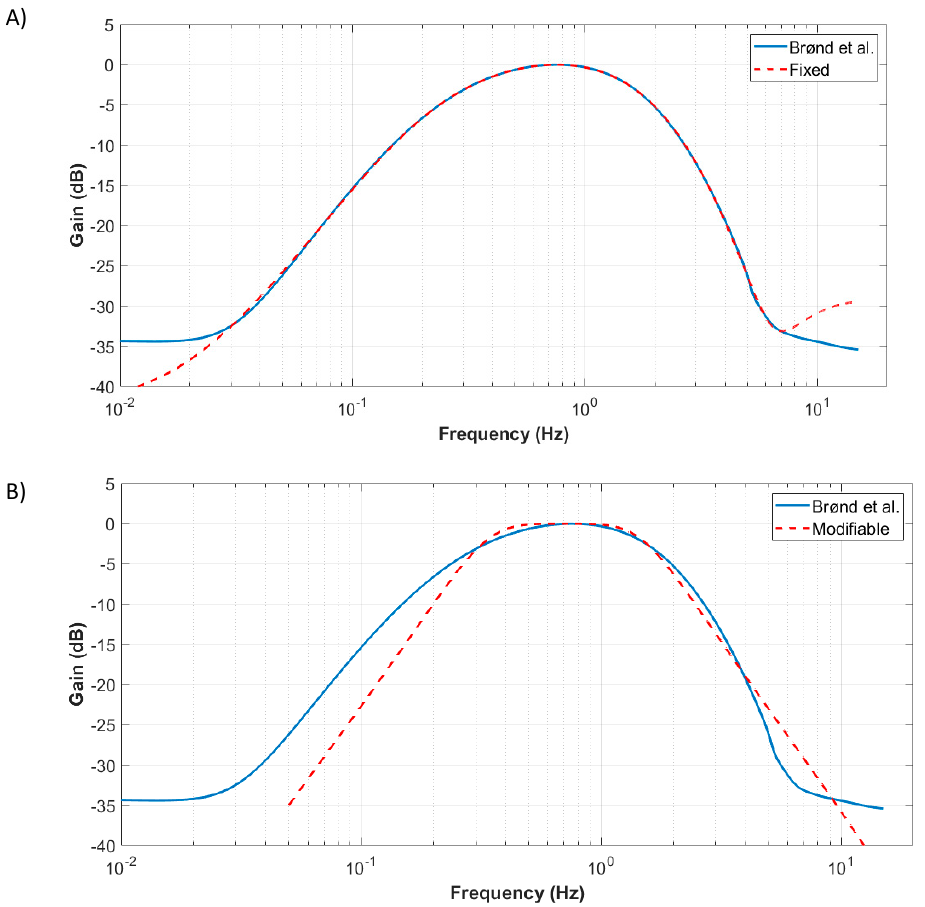
Figure 2. Bode diagrams of ( A ) the fixed bandwidth filter and ( B ) the modifiable bandwidth filter. The BrØnd et al. filter is from [10].